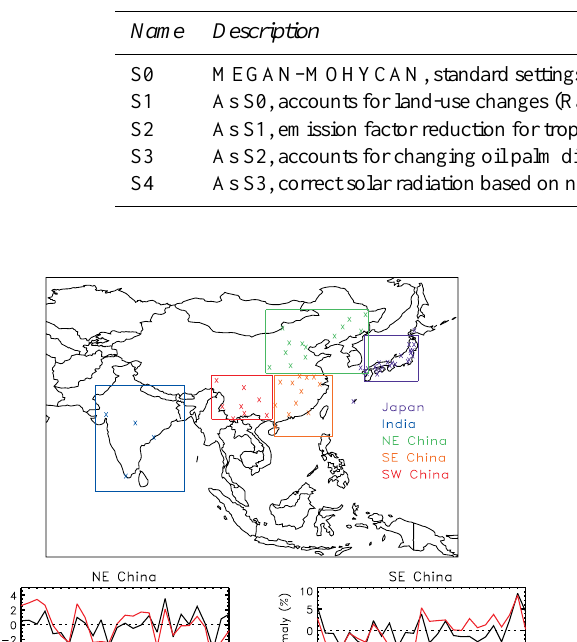
Table 1. Scenarios for calculating isoprene emissions.